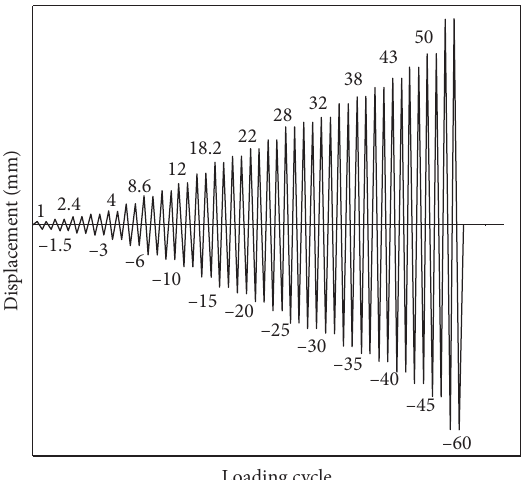
Figure 3: Loading protocol. The tests performed via displacement-controlled loading.